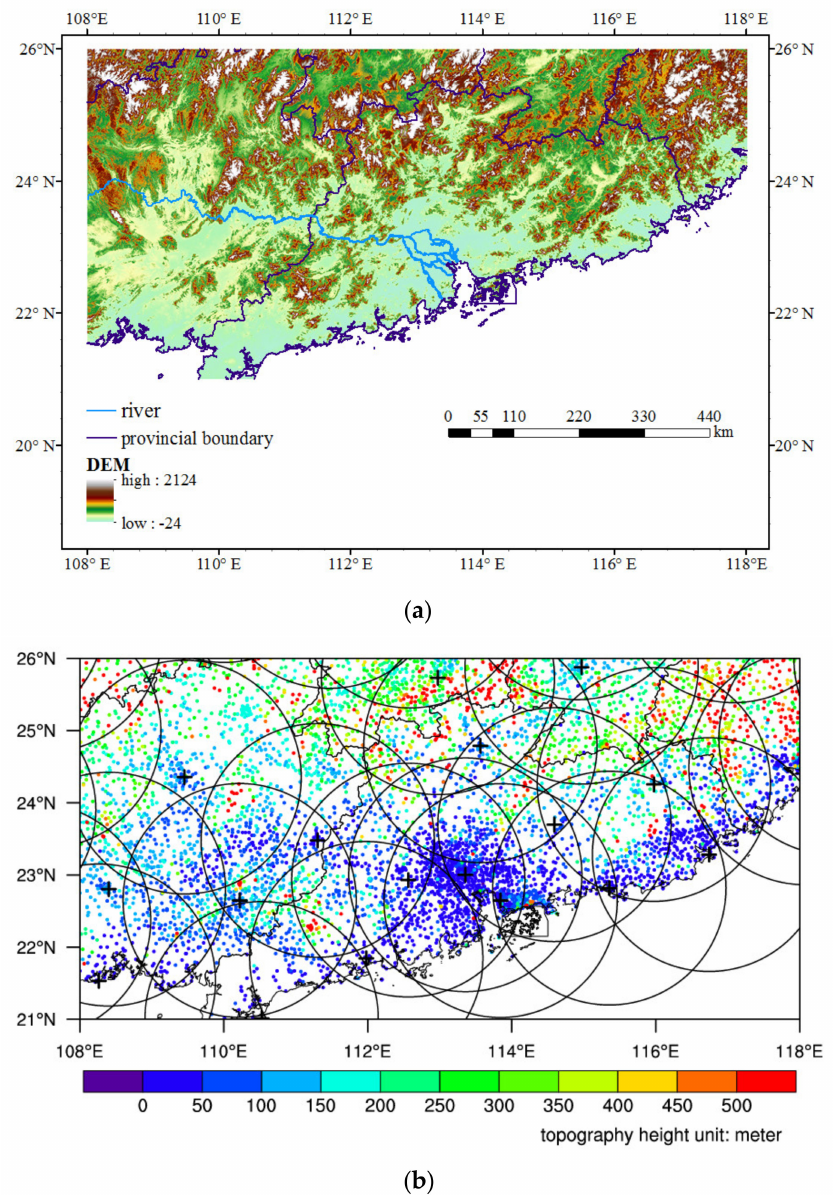
Figure 1. ( a ) The topography distribution in the study area of South China. ( b ) Schematic diagram of station distribution (indicated by dots) and radar locations (denoted by + and circles) in the South China region. The colors at each dot represent the topography height (unit: meter) at the correspond- ing station points. The 17 radars include Guangzhou (SA), Heyuan (SA), Meizhou (SA), Shantou (SA), Shanwei (SA), Shaoguan (SA), Shenzhen (SA), Yangjiang (SA), Zhanjiang (SA), Zhaoqing (SA), Liuzhou (SB), Nanning (SA), Wuzhou (SB), Fangchenggang (SA), Yulin (SA), Chenzhou (SA), and Ganzhou